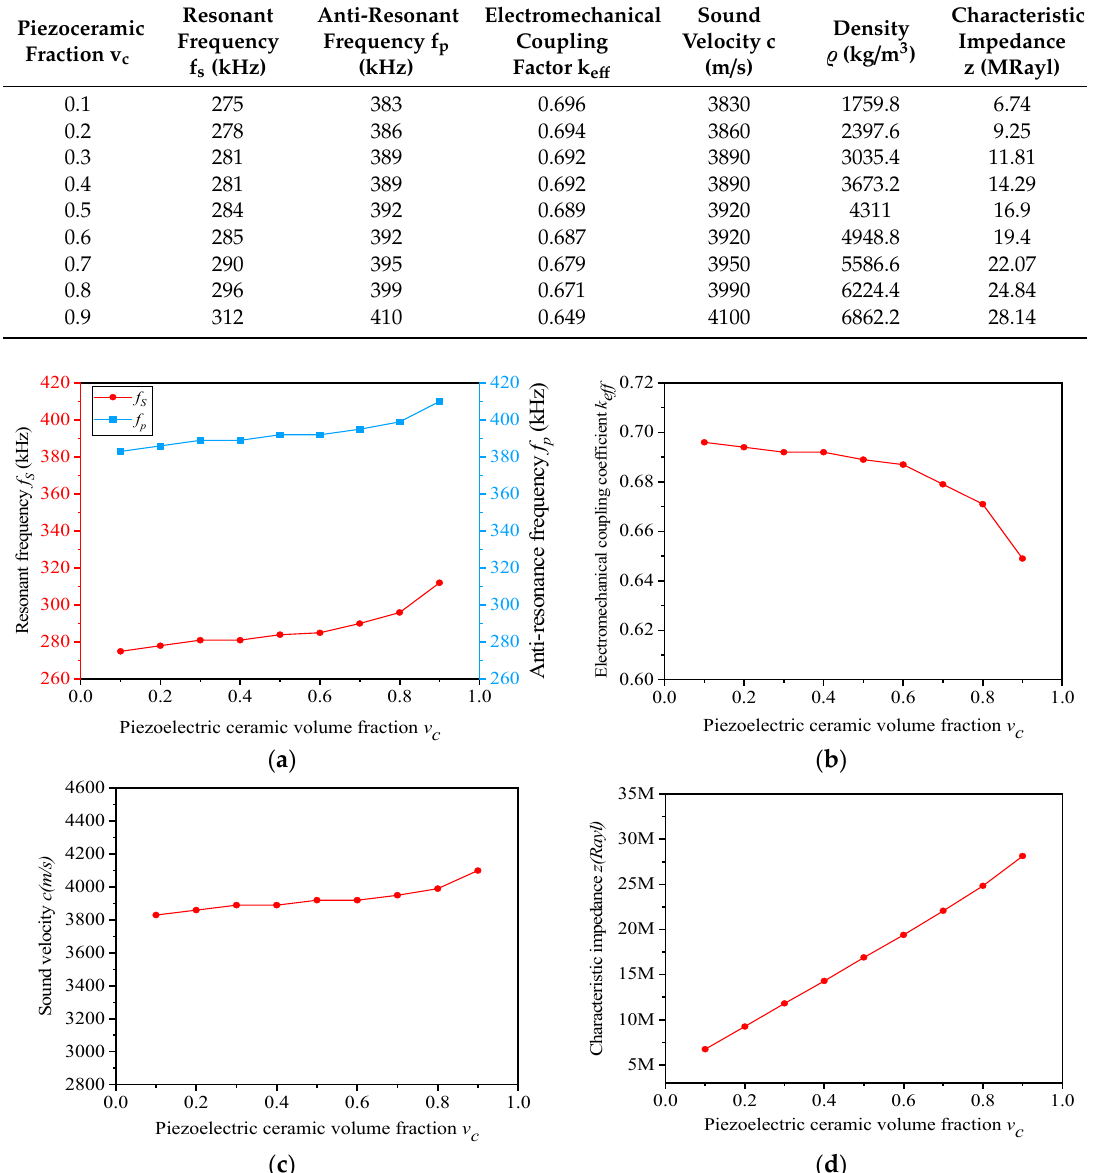
Figure 5. ( a – d ) Simulation performances of the novel composites with different v c (v s = 0.4).